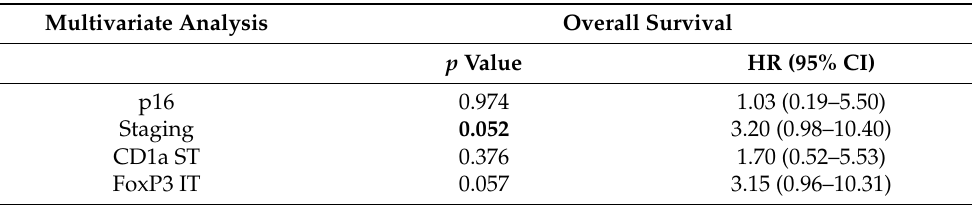
Table 7. Multivariate analysis evaluating the correlation between p16 positivity, staging, stromal CD1a, intratumoral FoxP3 and patient survival. p values < 0.05 are highlighted in bold.